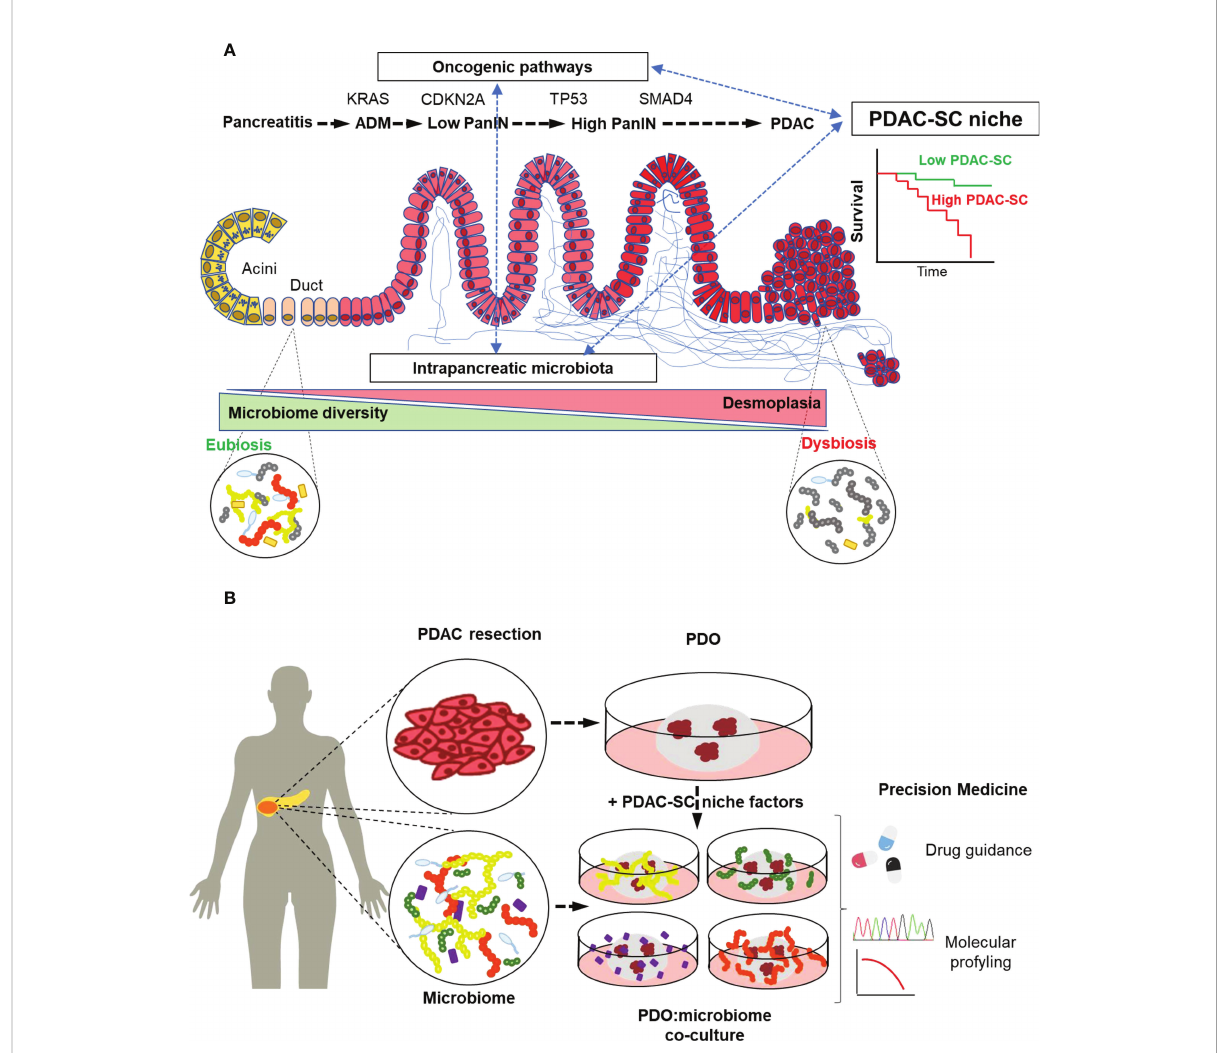
FIGURE 1 Intratumoral Microbiota may de fi ne PDAC stem cell niche, thereby constituting a diagnosis and prognosis biomarker. (A) In the development of PDAC, driver mutations accumulation is accompanied by an increasing desmoplastic reaction (blue lines) as a hallmark histopathological feature in PDAC stroma. Microbiota embedded in the desmoplastic stroma changes towards a dysbiotic low-diversity composition that might impact the PDAC stem cell niche by favoring tumor progression and resistance to chemotherapy. (B) Patient-derived organoids (PDOs) are generated mainly from PDAC resection containing PDAC cancer stem cells (PDAC-SC). PDOs can be co-cultured with the patient microbiota to recapitulate the PDAC-SC niche. This co-culture technique paves the way to the study of microbiome-focused precision medicine bench-to-beside approaches to overcome the lack of early diagnosis and therapy resistance in